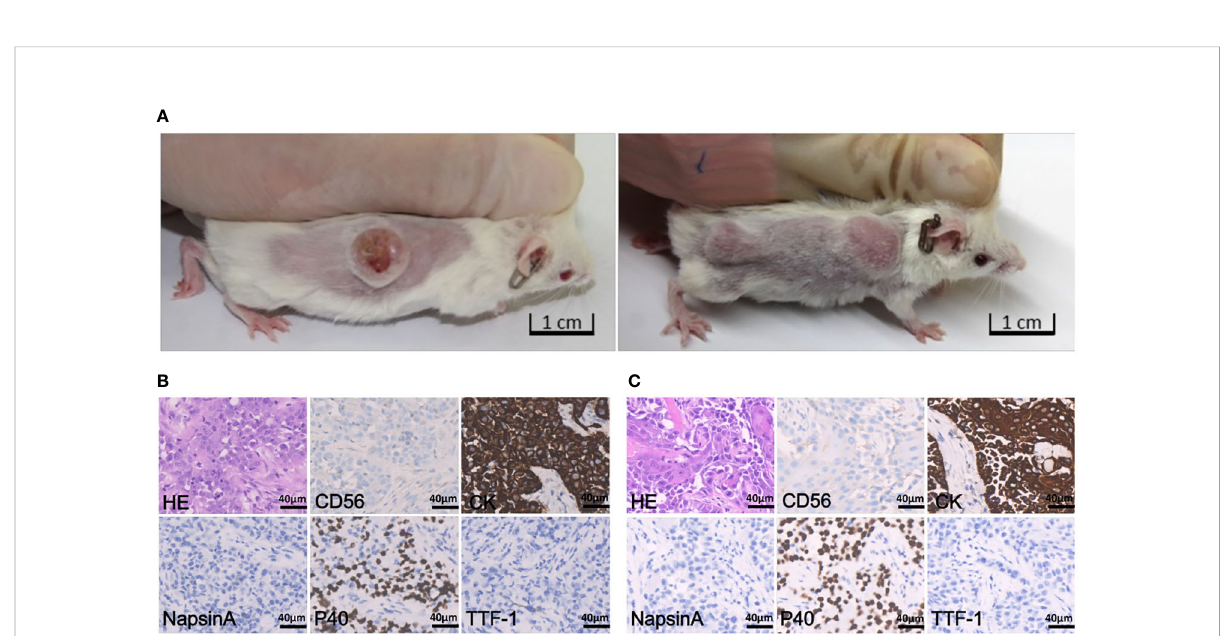
FIGURE 2 Tumor-bearing mice and histopathology staining. (A) Representative images of tumor-bearing PDX mice established from patient pretreatment tumor (left) and drug-resistant tumor (right), respectively. (B) H&E staining and IHC staining of tumor derived from pretreatment PDX (passage 3), which was negative for CD56, NapsinA and TTF-1, and positive for CK and P40; the scale bar represents 40 m m. (C) H&E and IHC staining of tumor derived from drug- resistant PDX (passage 2), which is negative for CD56, NapsinA and TTF-1, and positive for CK and P40; the scale bar is 40 m m.